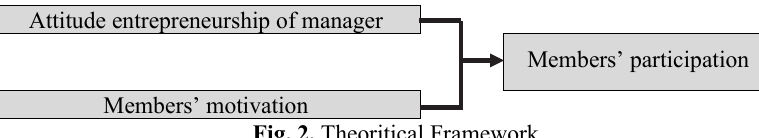
Fig. 2. Theoritical